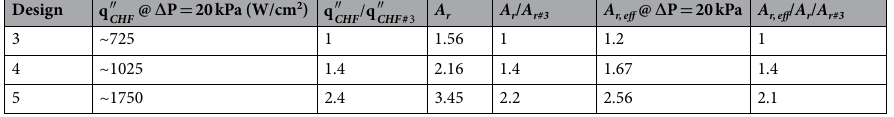
Table 2. Enhanced area and effective surface area